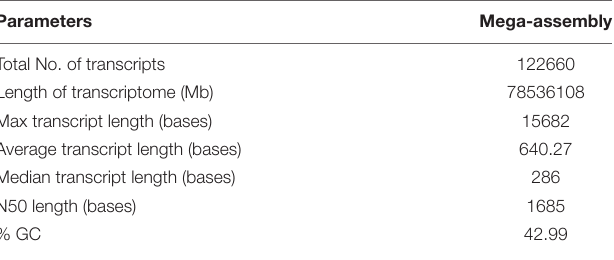
TABLE 1 | Assembly statistics of onion transcriptome in response to purple blotch (PB).